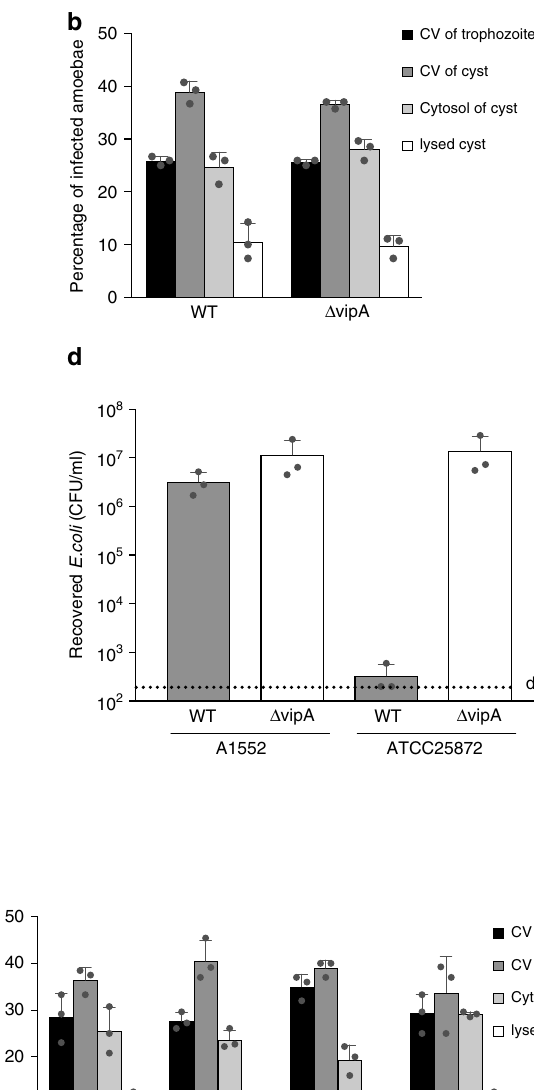
the amoeba was almost completely abrogated in hemolysin-